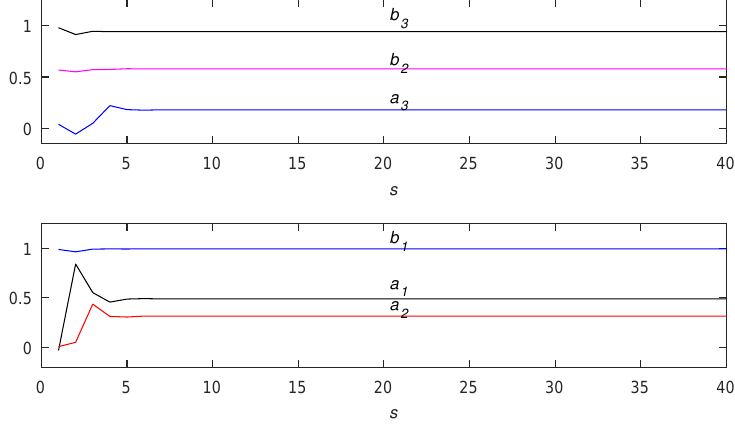
Figure 3. The VB parameter estimates against s with noise variance σ 2 = 0.50 2